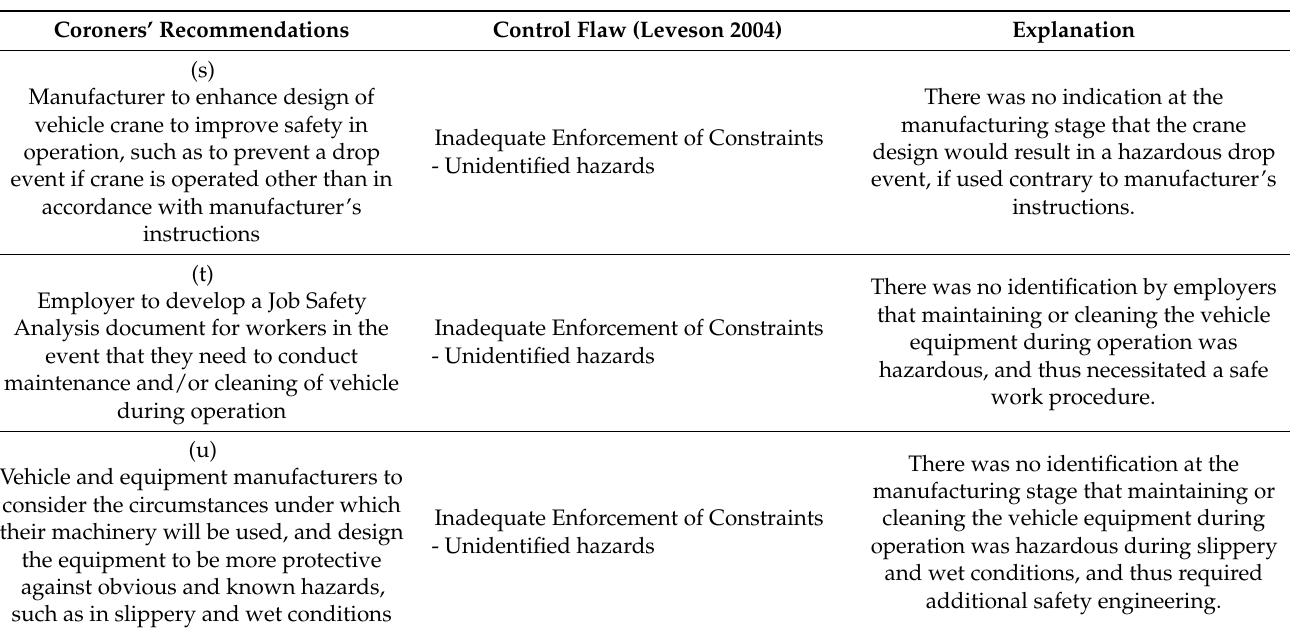
Table 8. Coroners’ Recommendations Mapped at STAMP Level 3—Strategic Management and Assigned to a Control Flaw ( n =